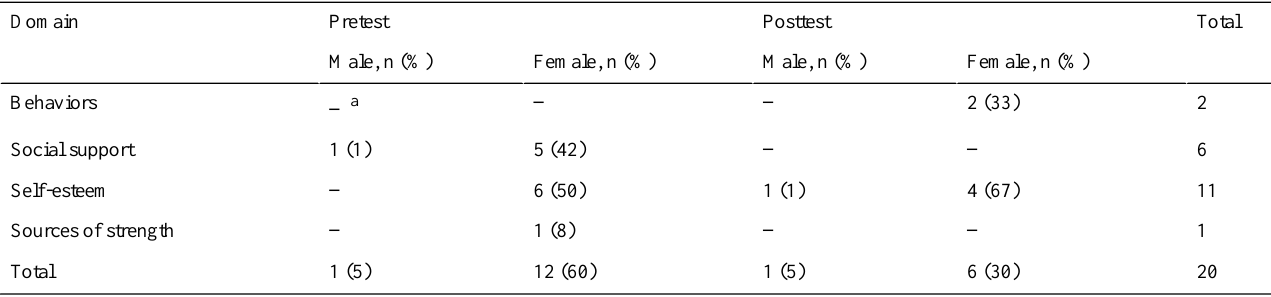
Table 4. High-risk responses by category, pretest and